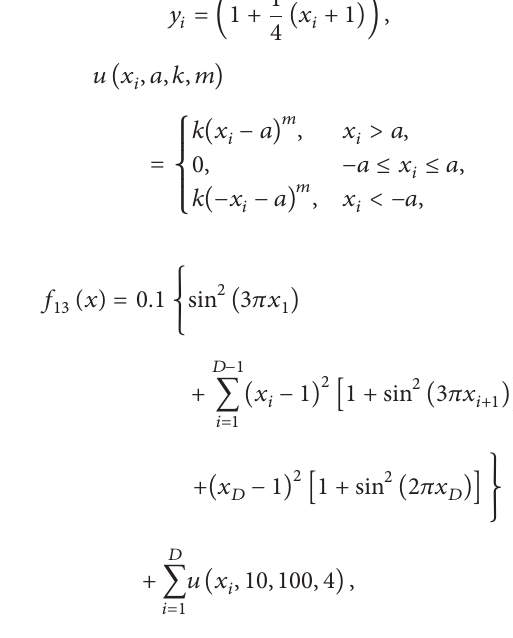
𝑓 = − 20 exp (−0.2√ 10